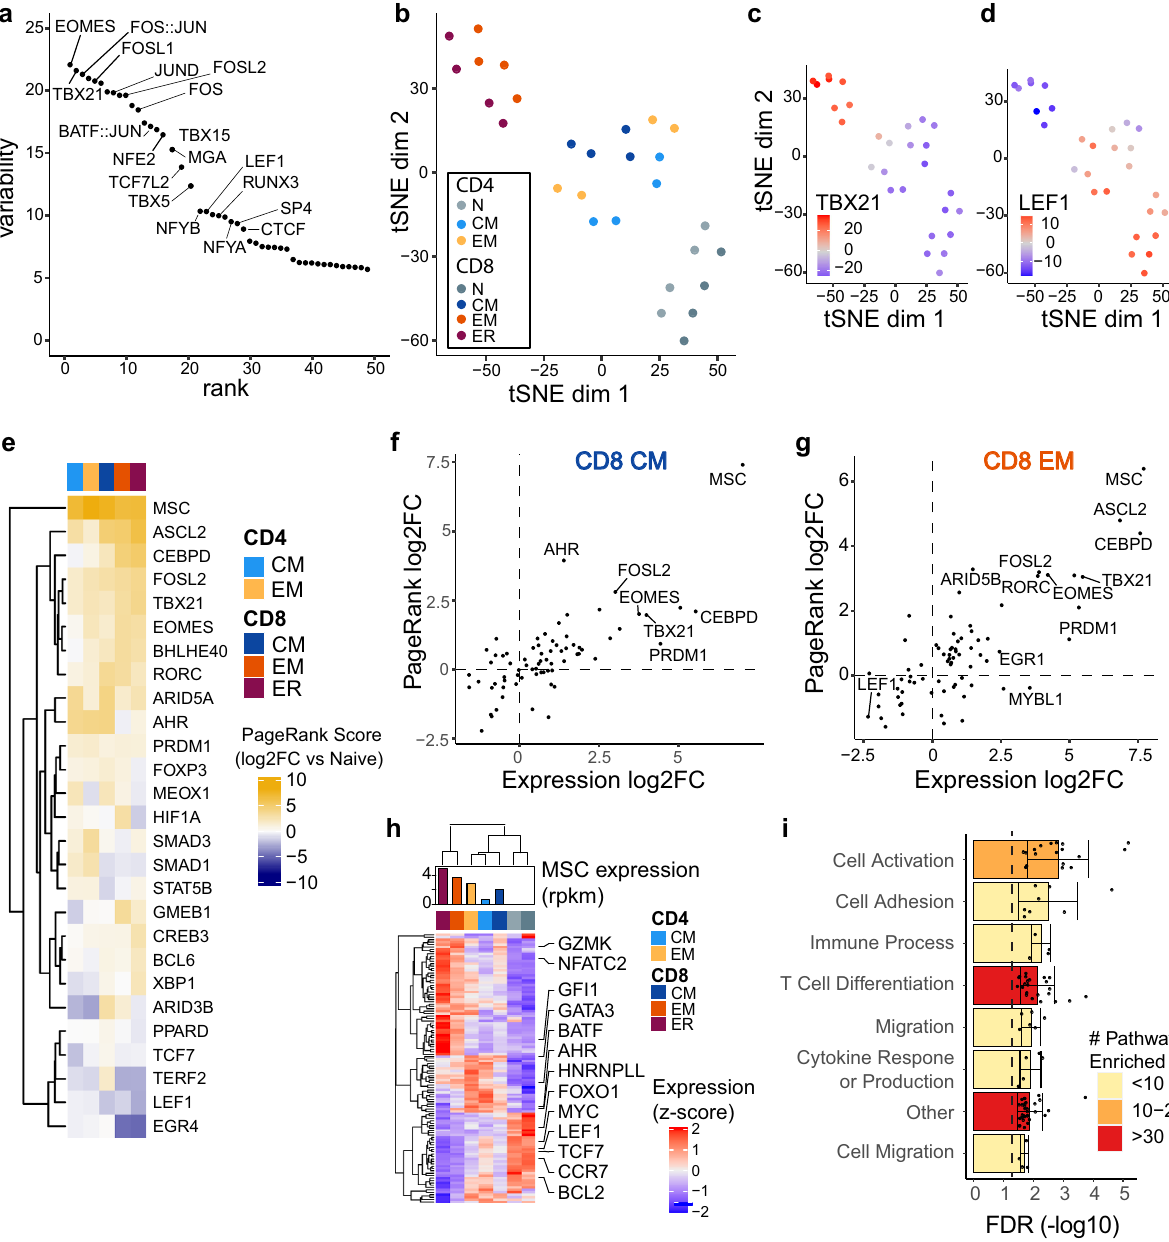
Fig. 5 bZIP, HMG, T-box, and bHLH factors differentiate MTC subsets by chromatin accessibility. a Plot showing the top 50 transcription factors ranked ( x -axis) according to variability (ChromVar) in chromatin accessibility ( y -axis) around their corresponding binding motifs. b tSNE plot showing reduced dimensional visualization of variability of chromatin accessibility data for each memory-subset sample at all differential sites. c, d tSNE plot from B colored by ChromVar variability around TBX21 (T-BET) and LEF1 binding motifs, respectively. e Heatmap of the log 2 -transformed fold change in PageRank statistics for each MTC subset (compared to naïve). f, g Scatter plots showing log 2 FC of RNA expression ( x -axis) and PageRank statistic log 2 FC ( y -axis) between memory and naïve samples for labeled CD8 + MTC subsets. h Heatmap of RNA expression from gene network of MSC transcription factor with bar plot showing expression of MSC in each subset. Data represent the mean expression of each cell subset. i Bar plot showing average gene set enrichment FDR corrected p -value from MSC network genes binned by T-cell-relevant categories. Error bars represent one standard deviation. Color corresponds to the number of pathways signi fi cantly enriched in each